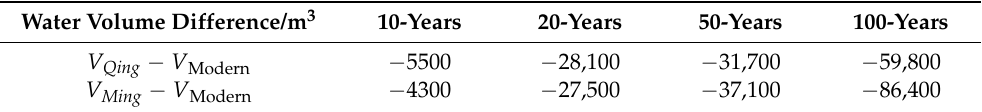
Figure 8. The total amount of surface water volume under the designed rainstorm in different Figure 8. periods. Table 6. Comparison of the peak value of the total amount of water volume.